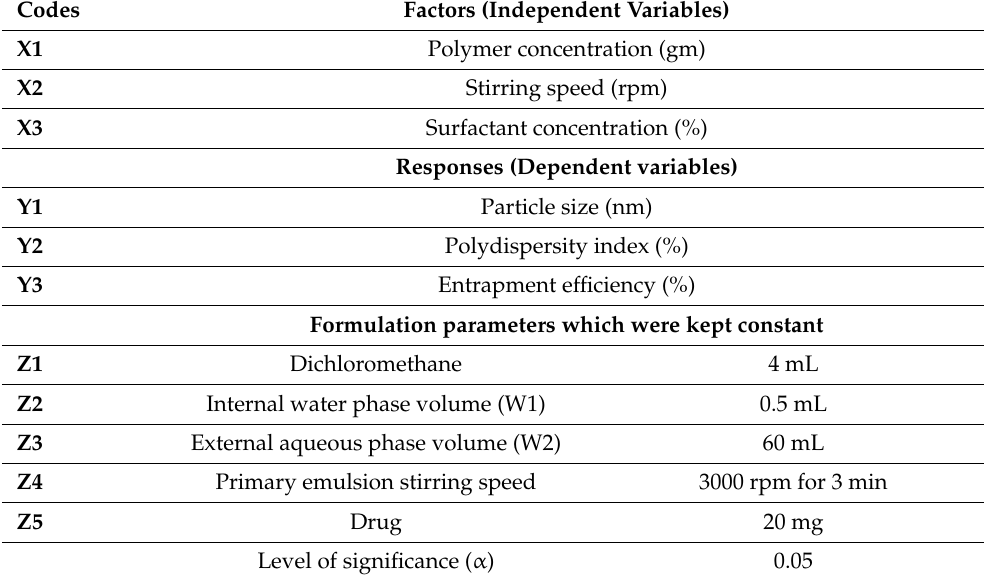
Table 1. Independent and dependent